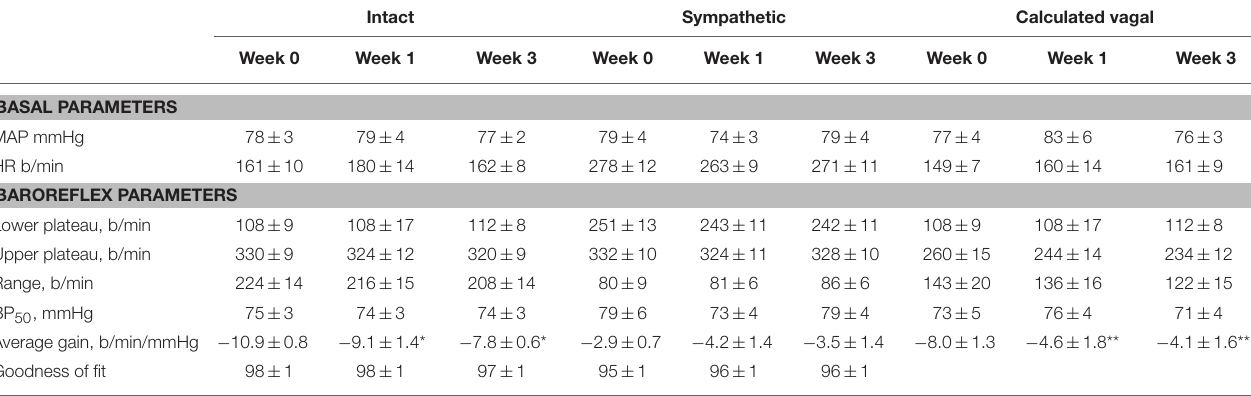
TABLE 4 | Average basal values and baroreflex parameters describing intact, sympathetic and calculated vagal MAP-HR curves before and at weeks 1 and 3 of subcutaneous administration of vehicle ( n =